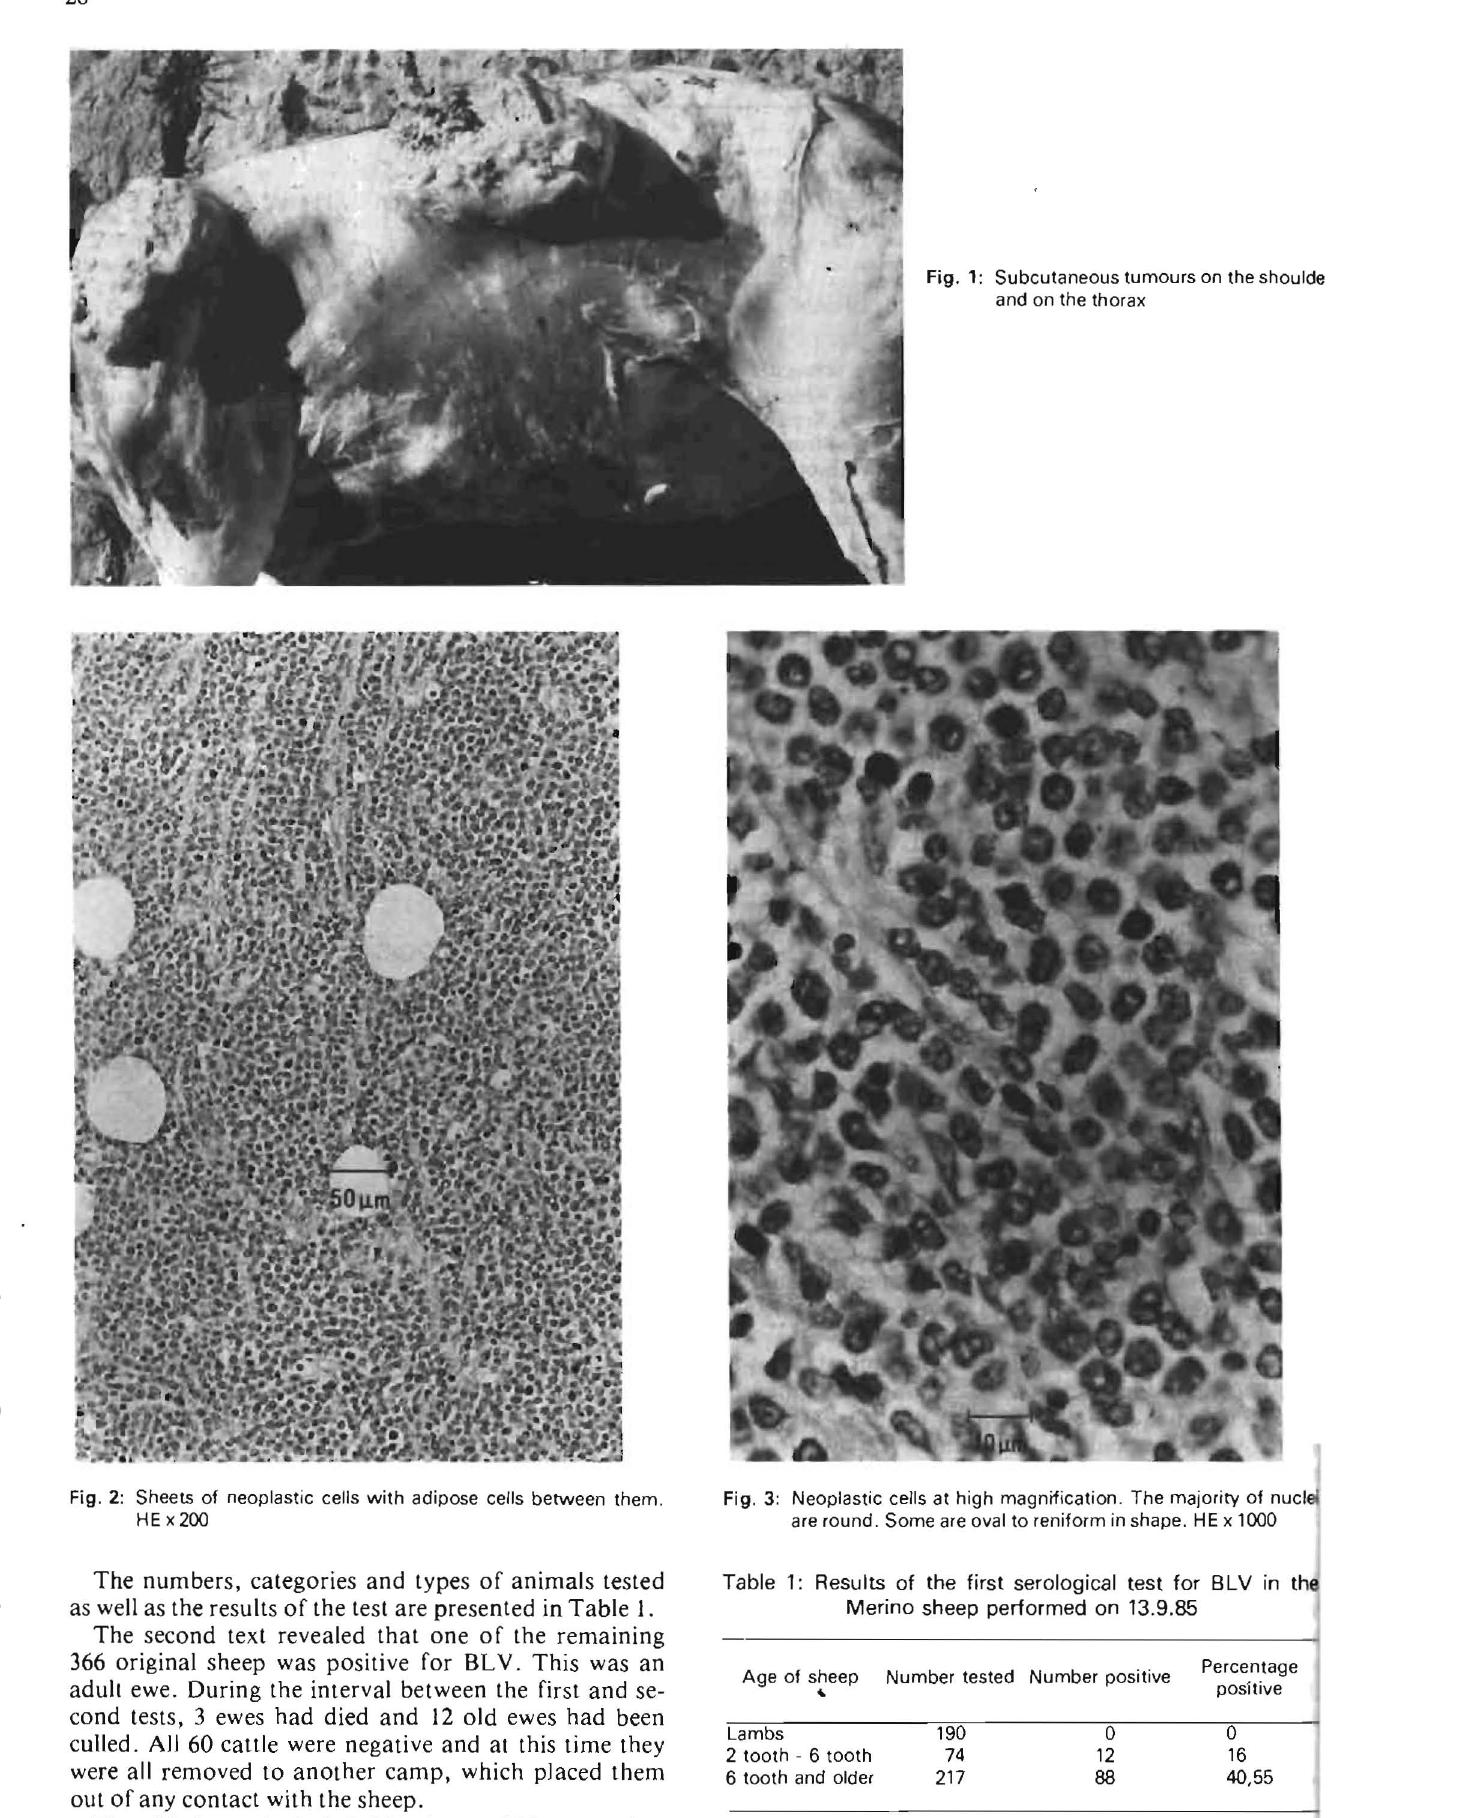
Fig. 3: Neoplastic cells at high magnification. The majority of nUcle( are round. Some are oval to reniform in shape. HE x 1000 Table 1: Results of the first serological test for BLY in the Merino sheep performed on